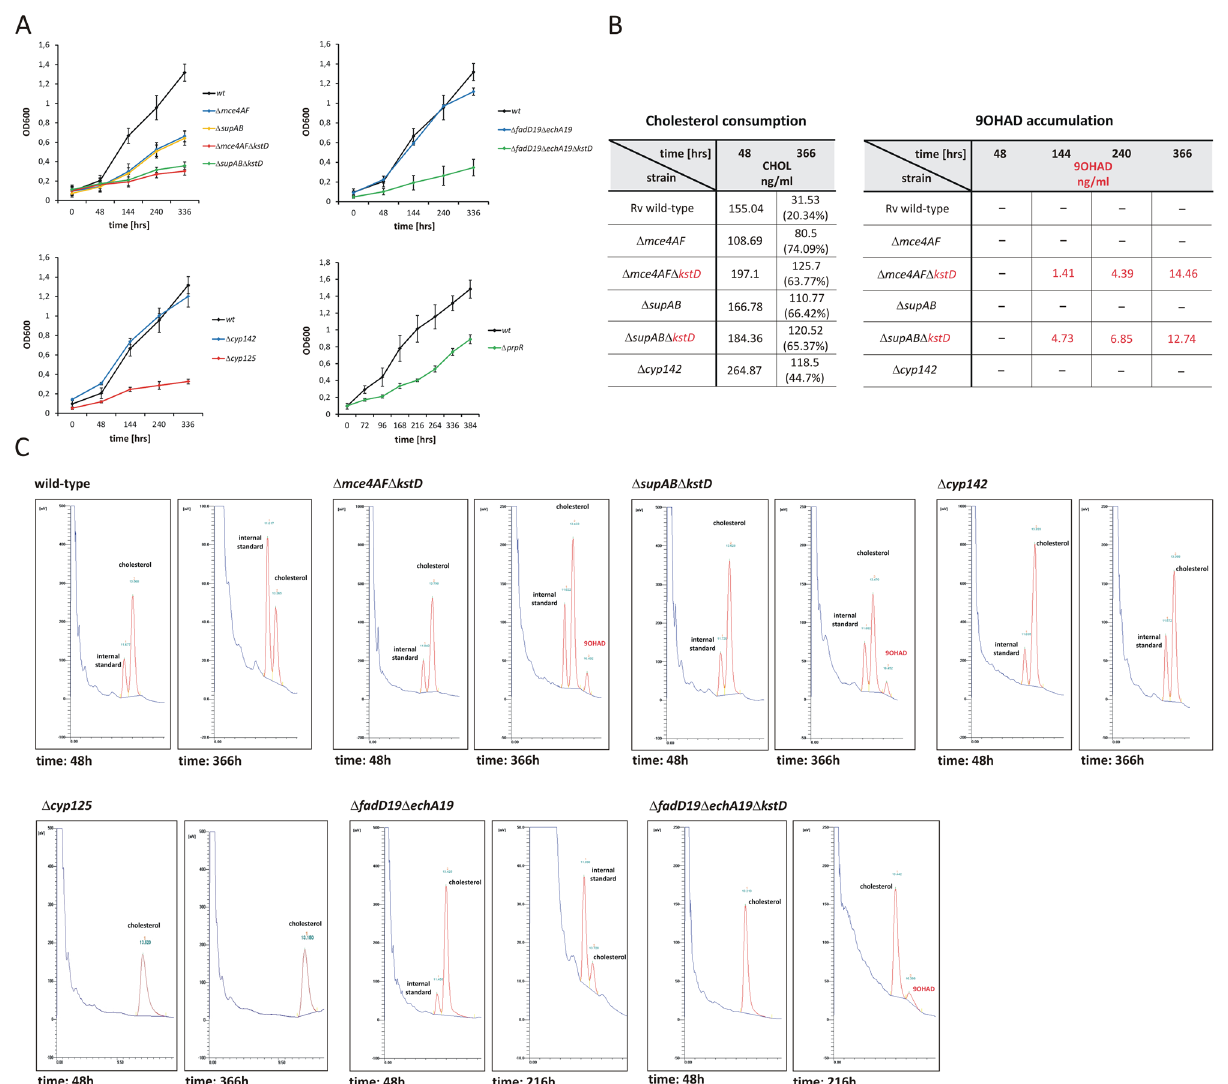
Figure 3. Phenotype of the Mtb mutants constructed in this study. ( A ) Growth rate analysis of the Mtb wild-type strain (wt) and Mtb mutants described in this study on mineral medium supplemented with 0.01% cholesterol. ( B ) Quantitative analysis of cholesterol bioconversion and 9-hydroxy-4-androstene- 3,17-dione (9OHAD) accumulation by the M. tuberculosis wild-type strain and the Mtb mutants ∆ mce4AF , ∆ mce4AF ∆ kstD , ∆ supAB , ∆ supAB ∆ kstD , Δ cyp142 growing in mineral medium supplemented with cholesterol as the sole source of carbon and energy, monitored by gas chromatography. Data concerning 9OHAD accumulation are marked red. The analysis was done in the selected time points. Equal amounts of the internal standard (4-androstene-3,11,17-trione) were added to each sample. The amounts of cholesterol and 9OHAD in the sample (nanograms per milliliter of the bacterial culture) were calculated from the ratio between the internal standard and the cholesterol and 9OHAD peaks. After adding cholesterol to the bacterial culture a 48-hour incubation was conducted for better cholesterol solubilization. Therefore, % of the initial amount of cholesterol in the sample was calculated considering the value measured at 48 hours as 100% ( C ) Chromatograms demonstrating cholesterol consumption and 9-hydroxy-4-androstene-3,17-dione (9OHAD) accumulation in M. tuberculosis wild-type strain and ∆ mce4AF ∆ kstD , ∆ supAB ∆ kstD , Δ cyp142 , Δ cyp125 , ∆ fadD19 ∆ echA19 , ∆ fadD19 ∆ echA19 ∆ kstD mutant cells. The selected time points are shown in the figure. Each time, the quantitative analysis was conducted, an equal amount of the internal standard (4-androstene-3,11,17-trione) was added to each